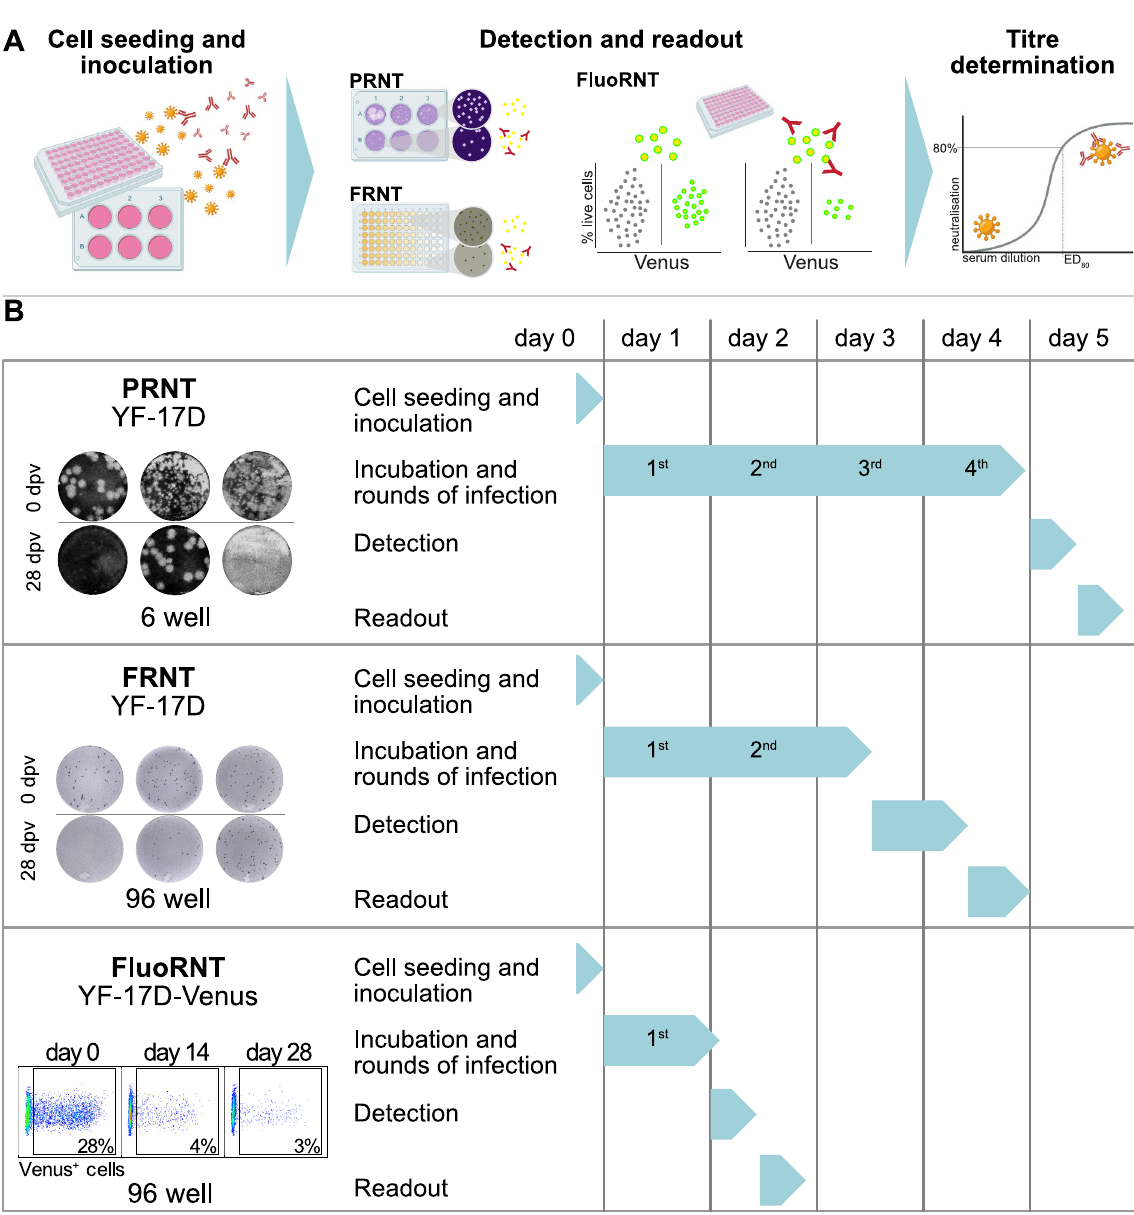
Fig 1. Comparison of scientific and practical features of the reduction neutralisation assays FluoRNT, PRNT and FRNT. (A) PRNT, FRNT, and FluoRNT are differentiated in their readout modes. (B) PRNT, FRNT, and FluoRNT are also differentiated in assay workflows and time requirements. FluoRNT has several practical advantages, including (i) avoiding multiple rounds of infection (2 nd – 4 th rounds of infection in FRNT and PRNT) that otherwise introduce and enhance assay variability; (ii) avoiding CMC addition and removal (PRNT and FRNT), staining (PRNT) or immunostaining (FRNT), and manual counting (PRNT) or image post-processing (FRNT): which are all manual steps that increase the probability to introduce handling errors. Additionally, FluoRNT (iii) is faster overall and has reduced hands-on assay time; (iv) is adaptable for high-throughput use; and (v) its assay progress can be followed noninvasively during run time.